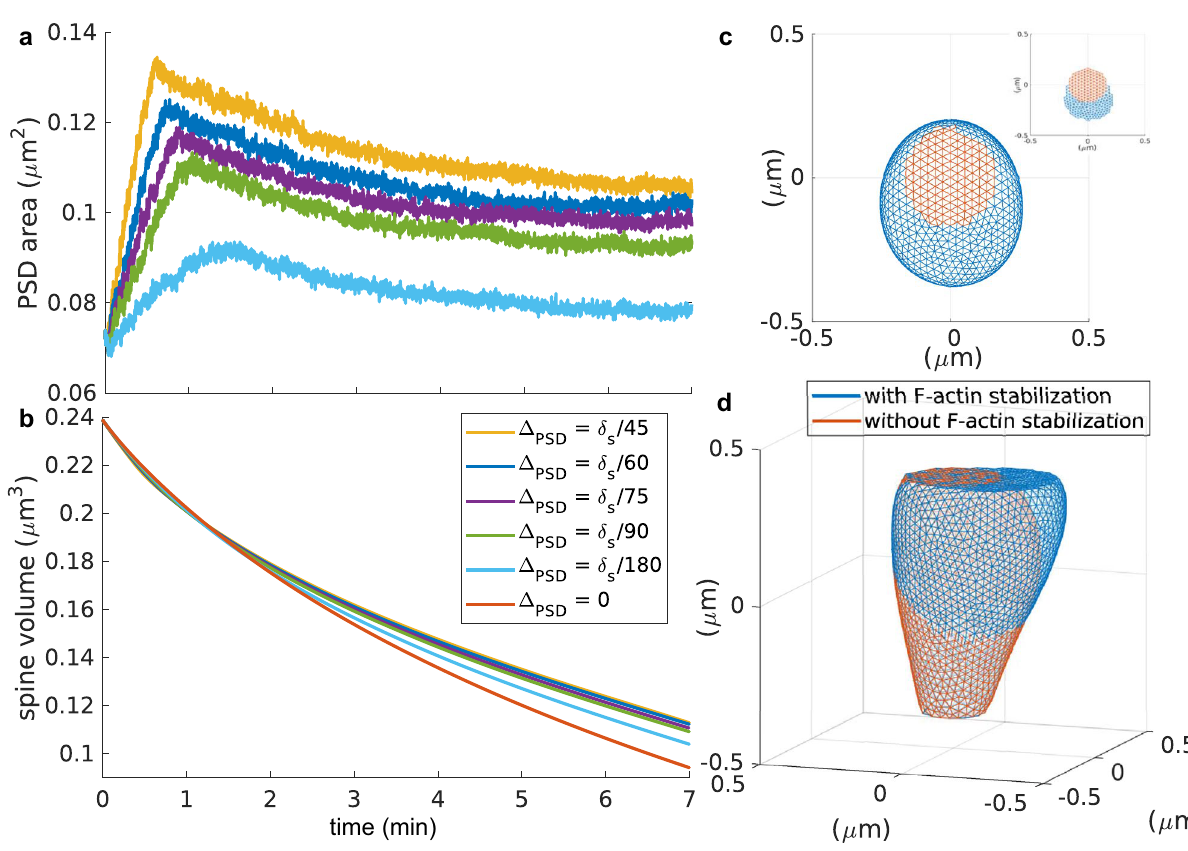
Figure 6. Stabilization of F-actin focus. ( a ) PSD surface area over time for different increments of (cid:31) PSD , color- coded as in ( b ). ( b ) Spine volume evolution over time for different increments of (cid:31) PSD . ( c ) Top view of a spine after 7 min of increasing the PSD size (blue, � PSD = δ s / 60 ) and without changing the PSD (orange). Inset shows only the mesh corresponding to the PSD. ( d ) Front view of the spines in ( c